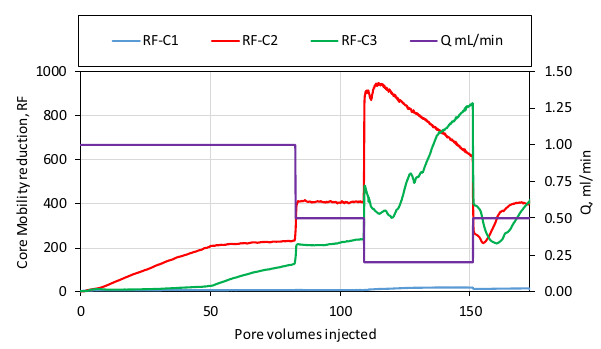
Fig. 12 Experiment 5, 1000 ppm A10 in SSW in unconsolidated sand cores. RF pm as a function of pore volumes injected. T1 = 20 °C, T2 = 60 °C and T3 = 80 °C. The volumetric injection rate is 1 ml/min ( ̇𝛾 pm ∼ 40s − 1 , ̇𝛾 ct = 165s − 1 ) from 0 to 83 pore volumes, and 0.5 ml/ min from 83–109 pore volumes, 0.2 ml/min from 109–154 pore vol- umes and 0.5 ml/min from 151–173 pore